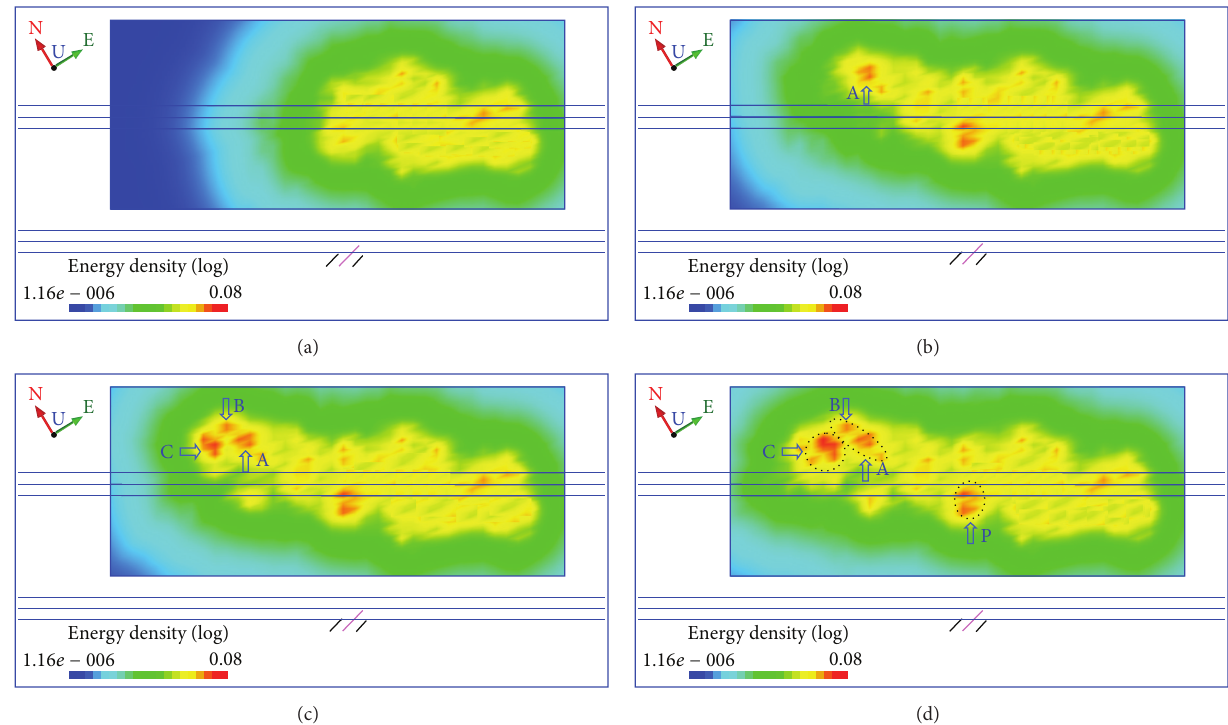
Figure 9: Topographical map of the evolution of microseismic energy density during TBM tunneling in diversion tunnel #3 (January 20 to February 21, 2011): (a) dissipated energy density cloud map for January 20–February 5, 2011; (b) dissipated energy density cloud map for January 20–February 10, 2011; (c) dissipated energy density cloud map for January 20–February 16, 2011; and (d) dissipated energy density cloud map for January 20–February 21, 2011.